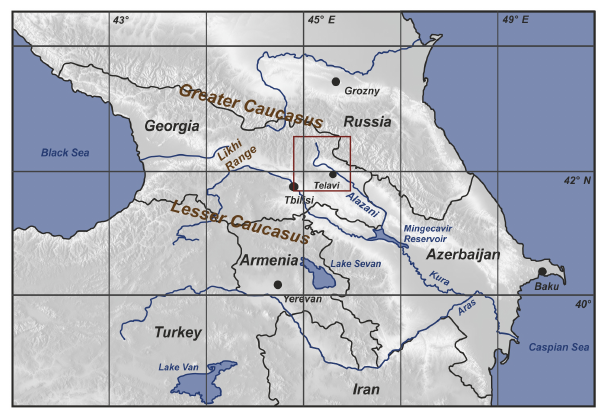
Figure 1. Overview of the Caucasus Region. The red rectangle marks the study